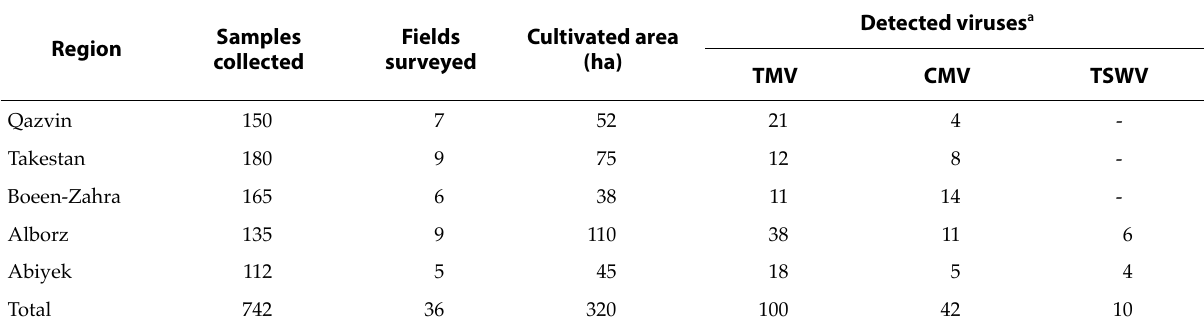
Table 1. Occurrence of natural virus infections in tomato fields in five regions of Qazvin province surveyed. Samples Fields Cultivated area Region collected surveyed